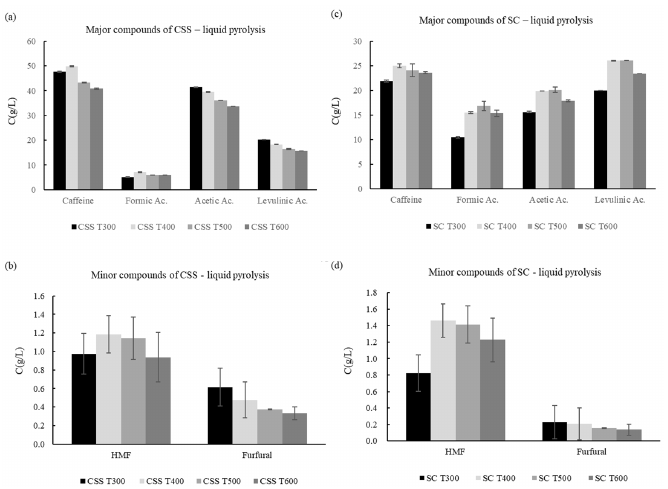
Figure 8. Acids’ and furfurals’ concentrations of pyrolysis liquids at different pyrolysis temperatures: ( a ) major compounds in CSS; ( b ) minor compounds in CSS; ( c ) major compounds in SC; ( d ) minor compounds in SC.